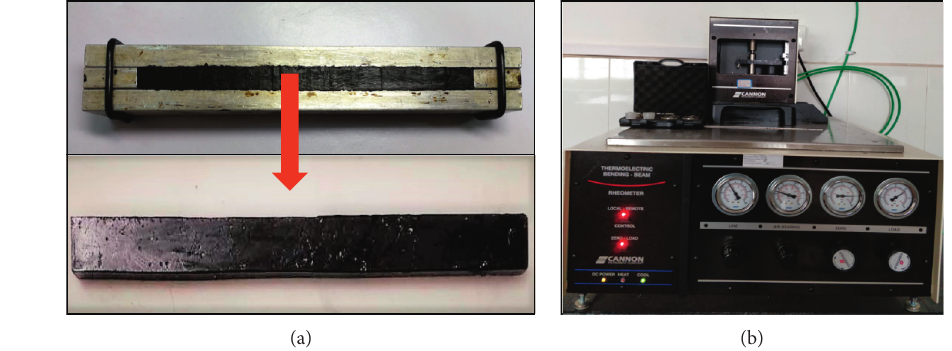
Figure 2: Thermoelectric bending beam rheometer and specimen.